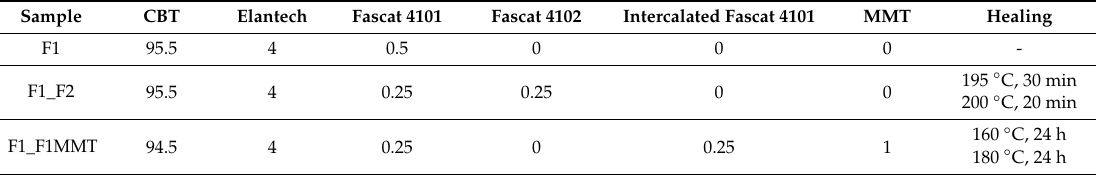
Table 1. Composition of the mixtures produced in wt.%.